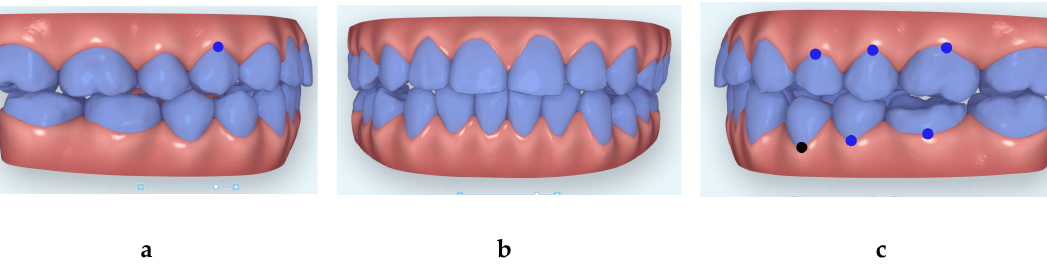
a a Figure 5. Images of the beginning of second Clincheck ( a ): right side; ( b ) frontal view and ( c ) left side . Figure 5. Images of the beginning of second Clincheck ( a ): right side; ( b ) frontal view and ( c ) left side . Figure 5. Images of the beginning of second Clincheck ( a ): right side; ( b ) frontal view and ( c ) left side. Figure 5. Images of the beginning of second Clincheck ( a ): right side; ( b ) frontal view and ( c ) left side . Figure 5. Images of the beginning of second Clincheck ( a ): right side; ( b ) frontal view and ( c ) left side .